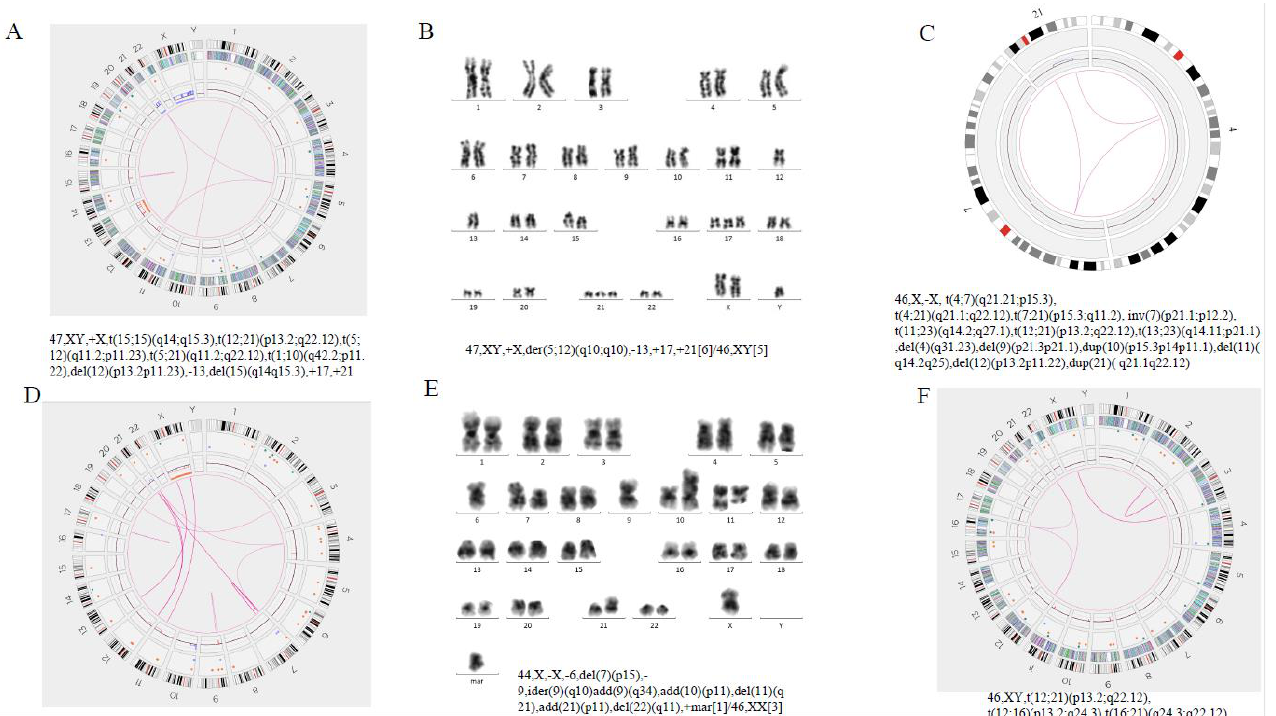
Figure 5. ( A,B ) Sample 114: A G-banded karyotype was performed and initially reported as the derivative chromosomes 5 and 12, add (17), add (21), add(X), del (13) in 6 metaphases with five metaphases with a normal karyotype. Optical genome mapping data confirm all known aberrations and show the presence of additional translocations t(15;15)(q14;q15.3), t(5; 12)(q11.2;p11.23), t(5;21)(q11.2;q22.12), t(1;10)(q42.2;p11. 22). ( C – E ) Sample 83: Optical genome mapping data showing a three-way translocation 46,XX,t(4;7;21)(q21.21;p15.3;q11.2); multiple deletions (4,9,11,12,X) and duplications (10,21) on chromosome segments were also shown, as well as translocation between multiple chromosomes. Karyotype did not indicate multiple translocations between chromosomes. ( F ) Sample 103: Optical genome mapping confirm a three-way translocation on chromosomes 12,16 and 21, while the G-banded karyotype (not represented in this plot) was normal.